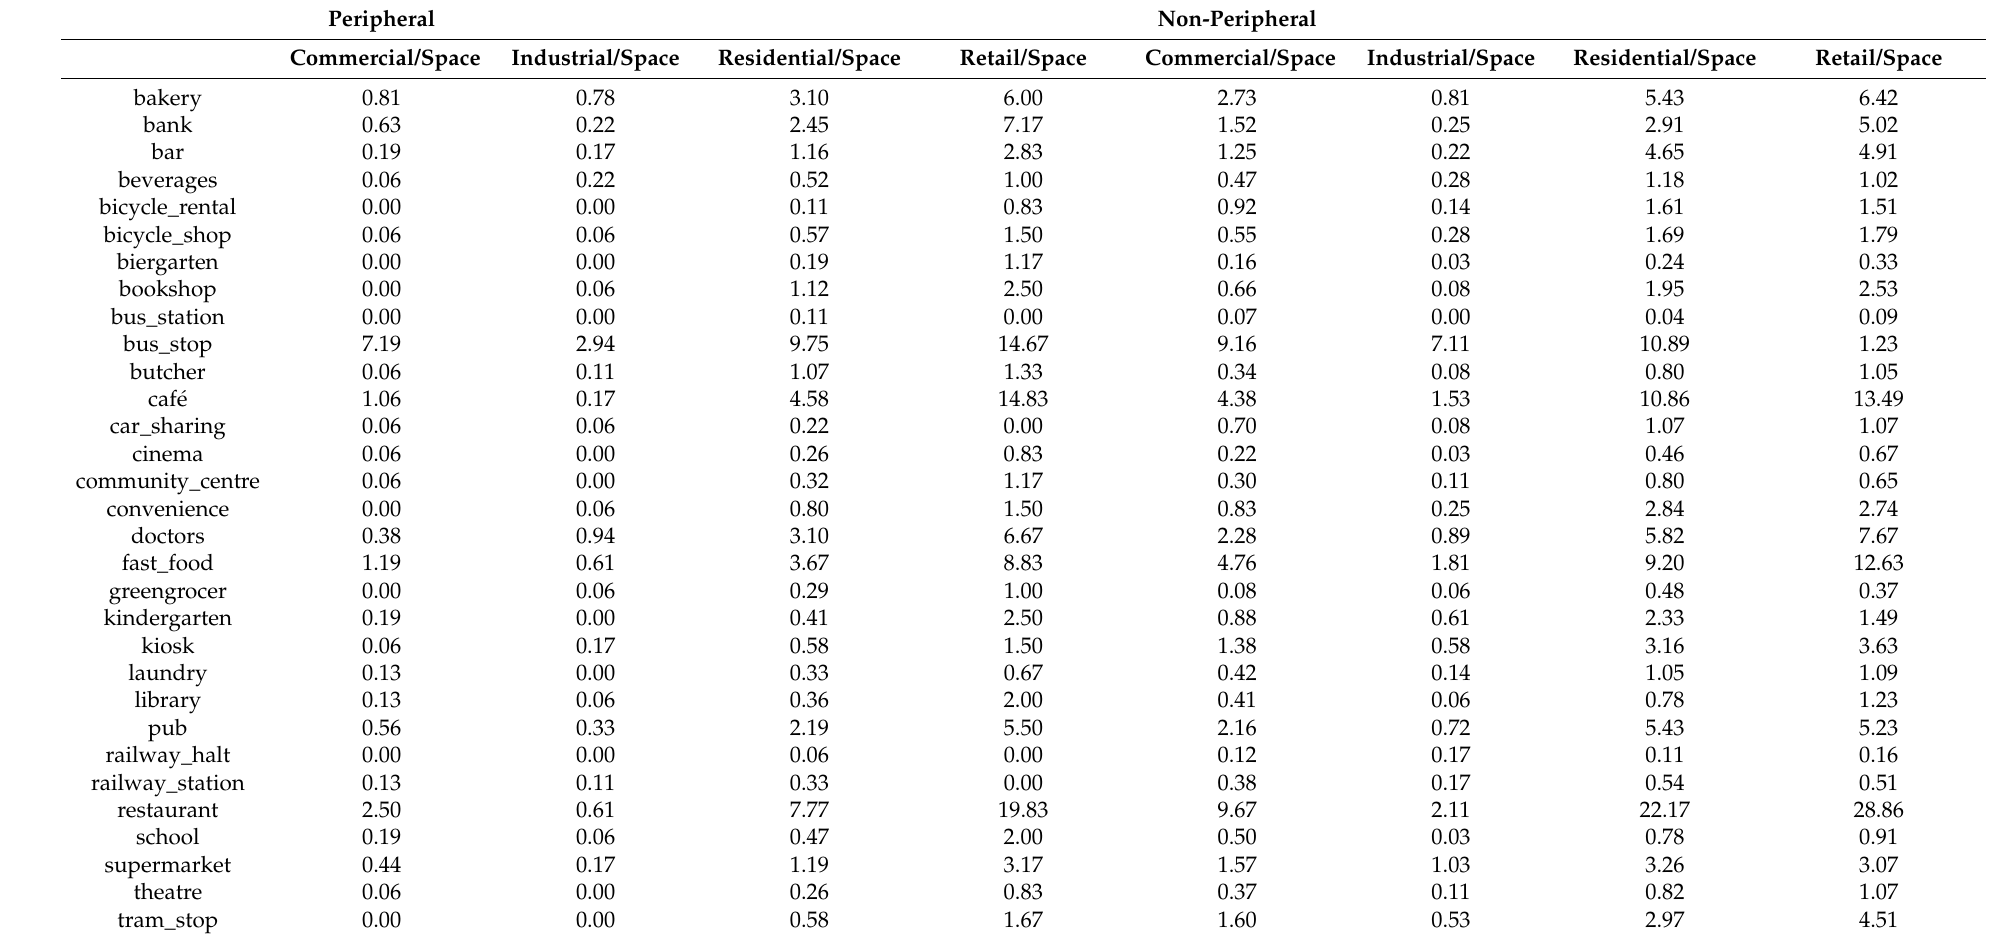
Table 3. List of the average quantity of POIs by land-use type related to peripheral and non-peripheral regions. Peripheral Non-Peripheral Commercial/Space Industrial/Space Residential/Space Retail/Space Commercial/Space Industrial/Space Residential/Space